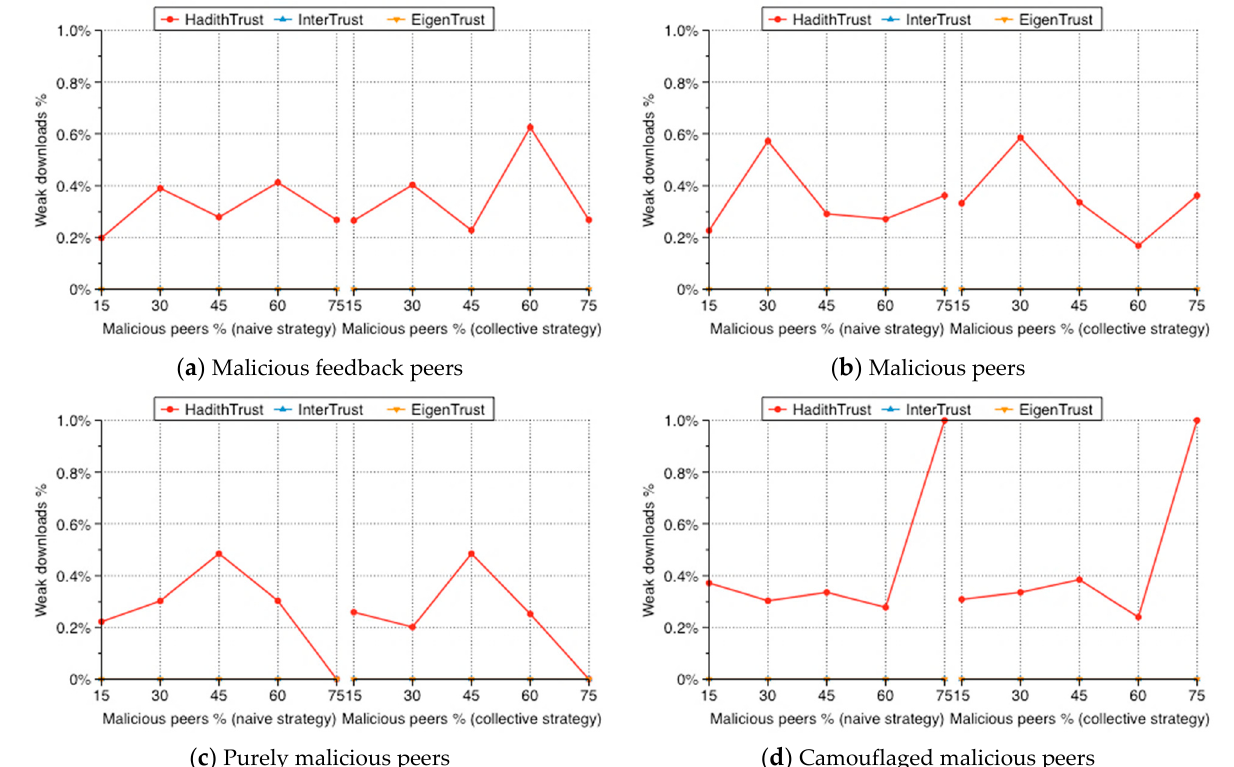
Figure 15. Percentage of weak downloads.